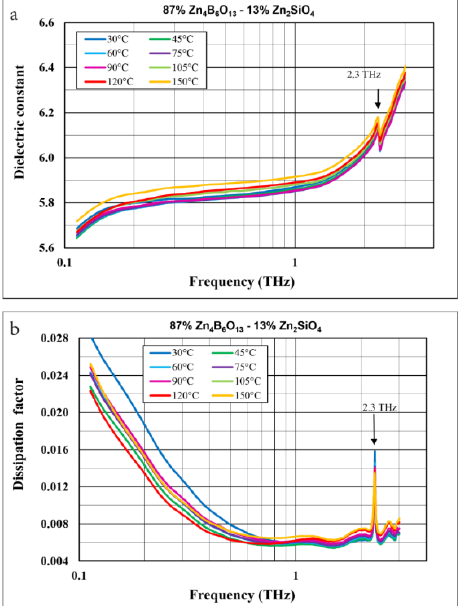
Figure 12. Dielectric constant ( a ) and dissipation factor ( b ) as a function of frequency in the range 0.12–3 THz and in the temperature range −30 to 150 °C for 87% Zn 4 B 6 O 13 –13% Zn 2 SiO 4 ceramic sintered at 930 °C. Materials 2021 , 14 , x FOR PEER REVIEW 11 of 14